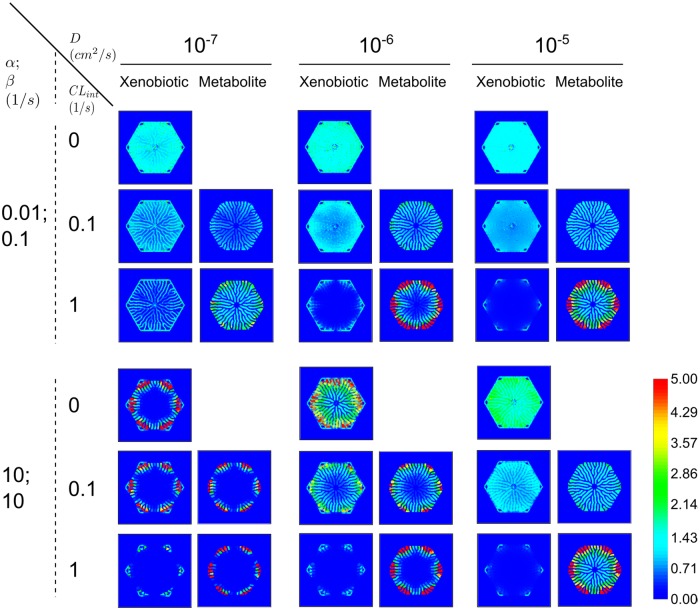
Transient xenobiotic and metabolite concentrations at t = 20 s in select PERSISTENT simulations.(α, β) pairs are (0.01, 0.1/s) and (10, 10/s) in upper and lower panels, respectively. In each panel, CLint, from top to bottom row, are 0/s, 0.1/s, and 1/s, respectively. Ds, from left to right column, are 10−7, 10−6, and 10−5
cm2/s, respectively. Color scale has units mmol/L. See Section 3 in S1 Text and S1 Animations for animations of these simulations.